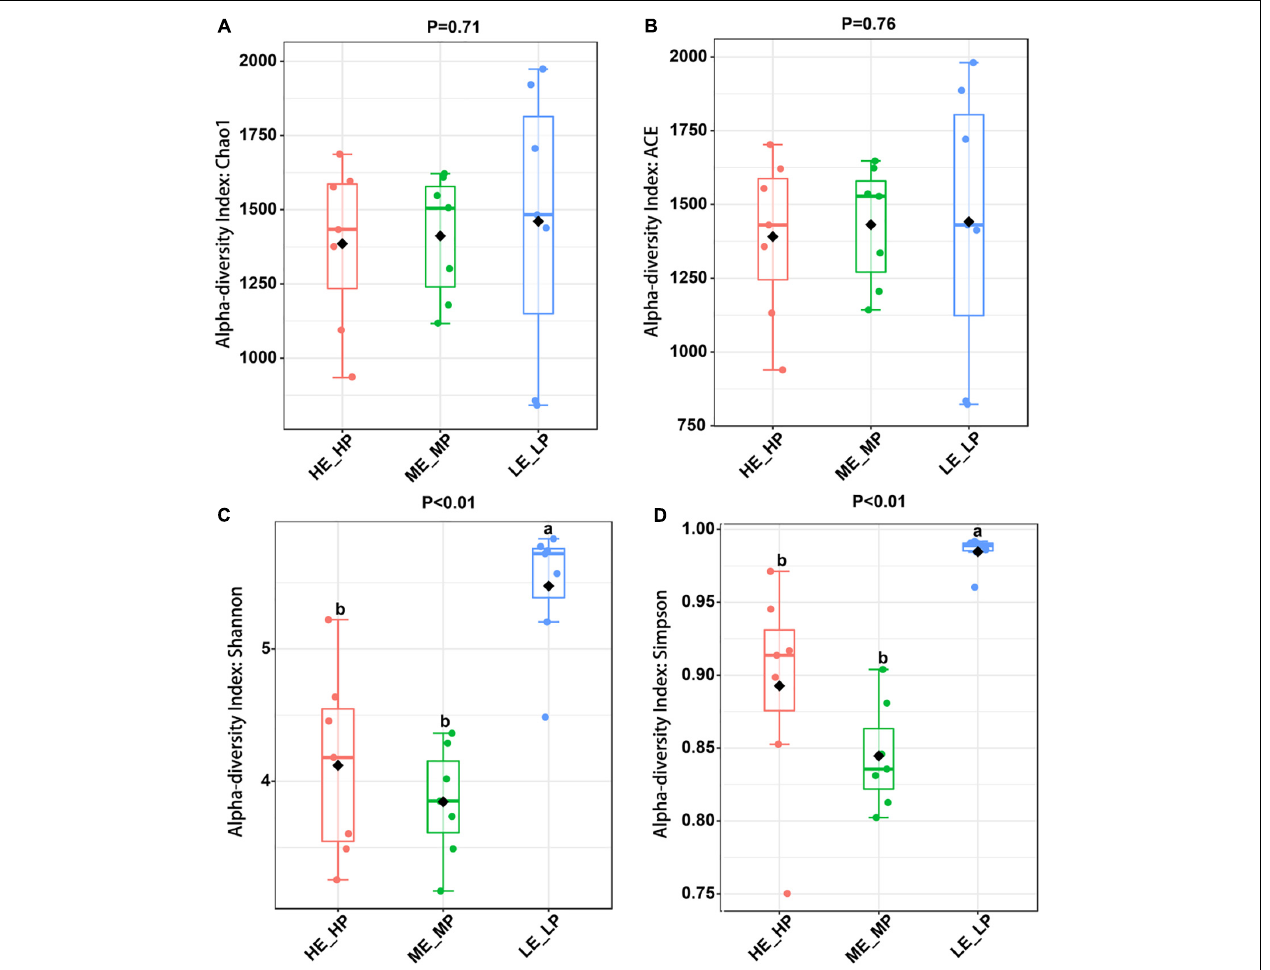
FIGURE 2 | Alpha diversity analysis of rumen microbiota in different nitrogen utilization efficiency groups. (A) Chao 1 index among the HE_HP cows, ME_MP cows, and LE_LP cows. (B) ACE index among the HE_HP cows, ME_MP cows, and LE_LP cows. (C) Shannon index among the HE_HP cows, ME_MP cows, and LE_LP cows. (D) Simpson index among the HE_HP cows, ME_MP cows, and LE_LP cows.